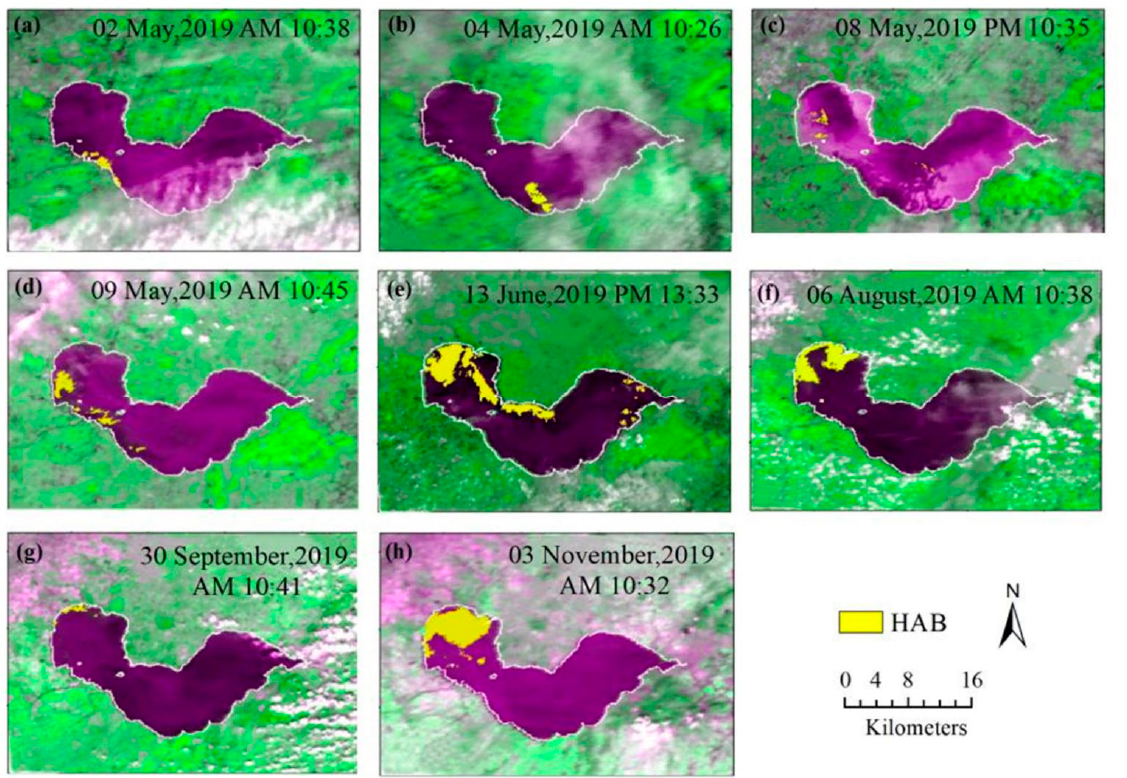
Figure 6. Spatial distribution of HAB in Chaohu Lake from visual interpretation.: ( a ) HAB distribution at 10:38 on May 2, ( b ) HAB distribution at 10:26 on May 4, ( c ) HAB distribution at 10:35 on May 8, ( d ) HAB distribution at 10:45 on May 9, ( e ) HAB distribution at 13:33 on June 13, ( f ) HAB distribution at 10:38 on August 6, ( g ) HAB distribution at 10:41 on Sep- tember 30, ( h ) HAB distribution at 10:32 on November 3.